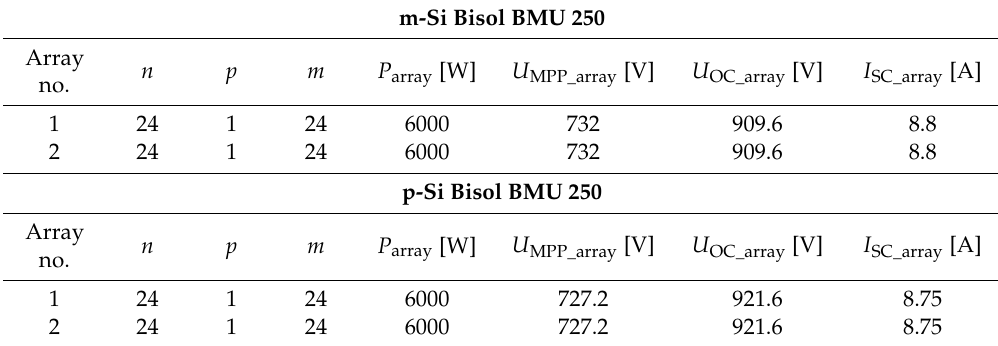
Table 8. PV plant configurations for the 12 kW PV